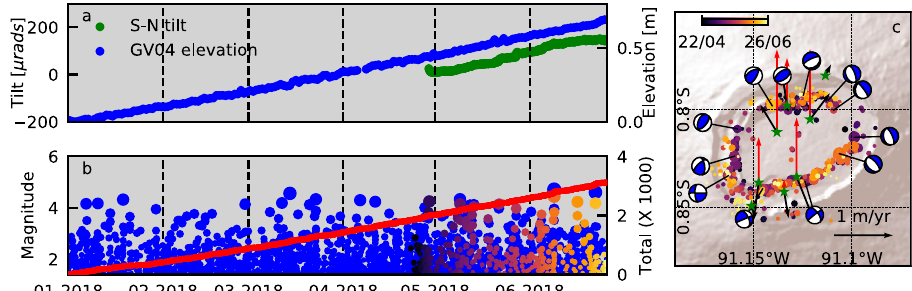
Fig. 3 Deformation and seismicity during fi nal pre-eruptive phase (01 January 2018 – 26 June 2018) at Sierra Negra volcano. A Uplift recorded at GV04 and tilt (positive to the S) recorded at SN14 (Fig. 1B); B Magnitudes of earthquakes (circles) and total number with M > 1.4 (red line) detected at VCH1 (blue) and located by the IGUANA network (coloured by time). C Epicentres of earthquakes, lower-hemispherical projections of focal mechanisms, and average horizontal (black) and vertical (red) displacement rate vectors for 22 April 2018 – 26 June